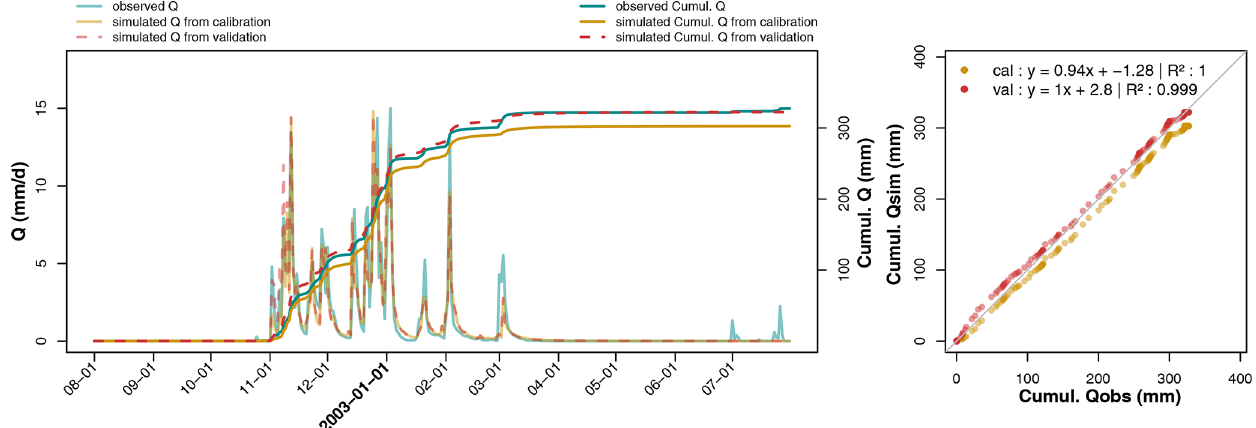
Figure 9. Hydrographs of observed and predicted discharges on calibration (parameter set derived from sub-period P2) and evaluation (pa- rameter set from sub-period P1) recorded at La Jaillière in 2002–2003. Predicted cumulative discharges are directly compared to observations.